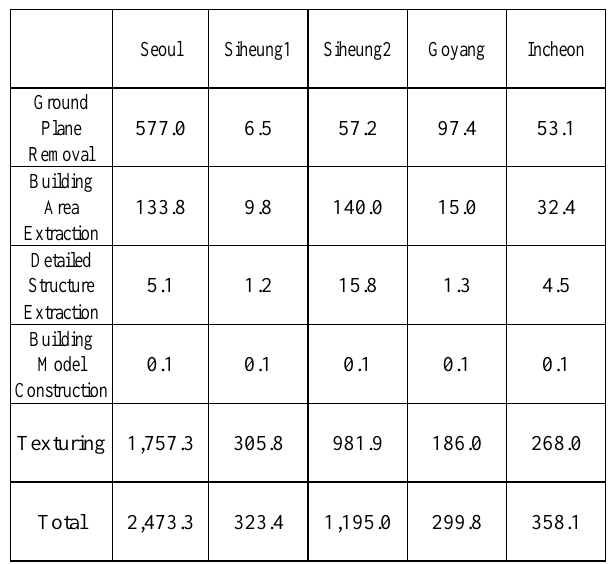
Table 3. Processing time (in